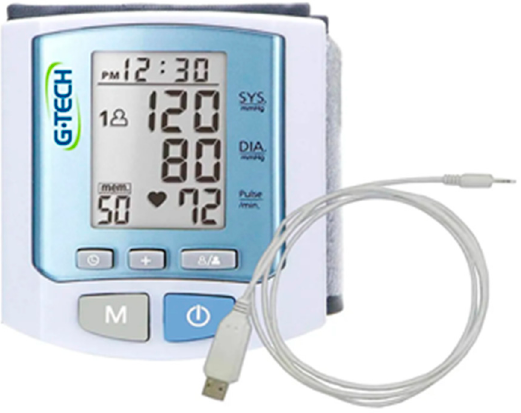
Figure 10. Illustration of the commercial blood pressure meter utilized.